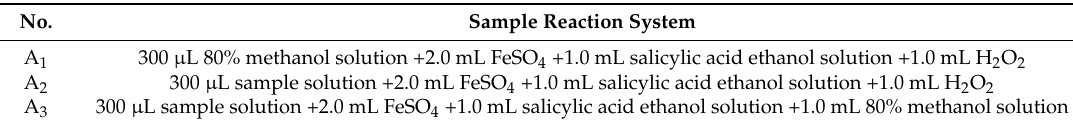
Table 3. Hydroxyl radical